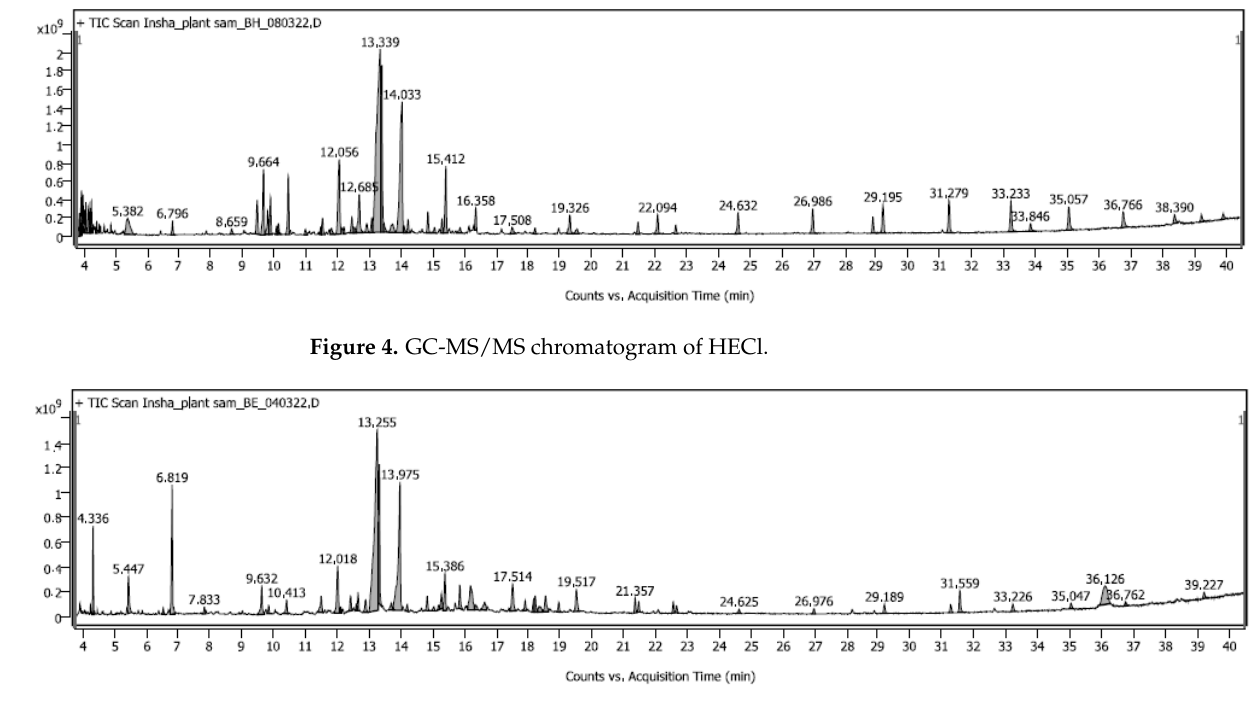
Figure 5. GC-MS/MS chromatogram of EECl.